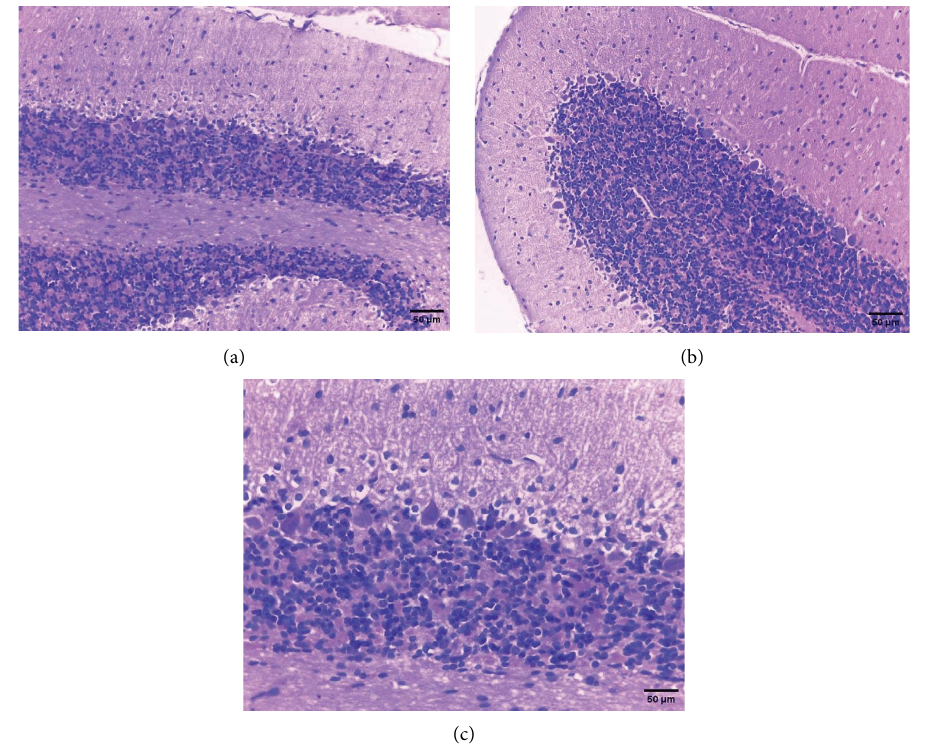
Figure 5: Photomicrograph showing normal rat brain (cerebellum), section (a and c) taken from rats in group III (1000mg/kg), section (b) taken from rats in group IV (control); H and E stain, 200x (a and b), and 400x (c)